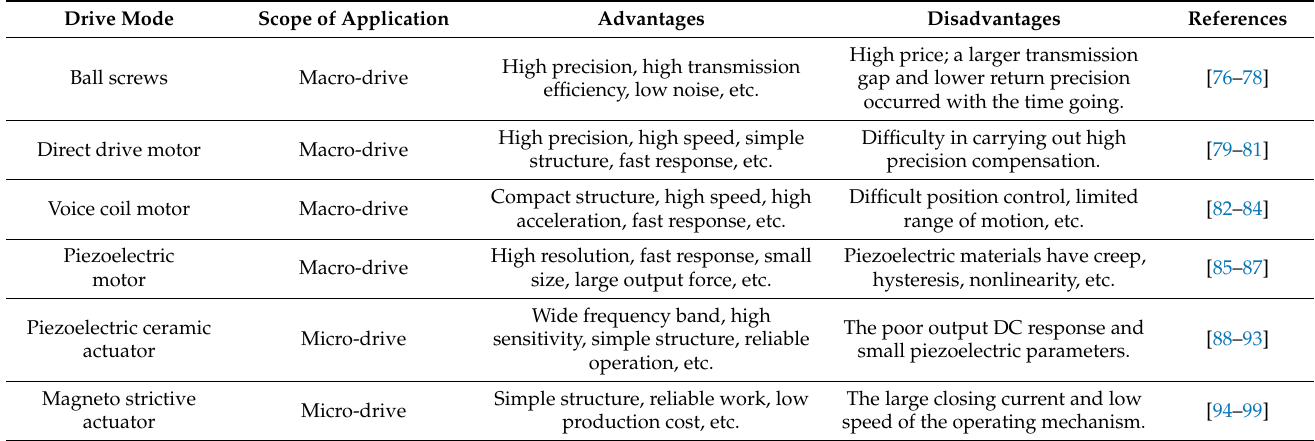
Table 3. Comparison of driver characteristics.